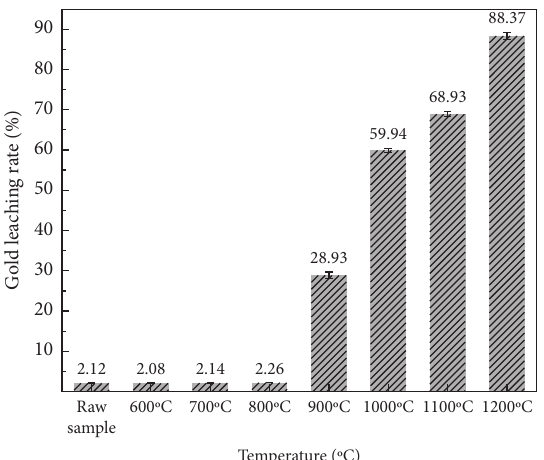
Figure 13: Results of cyanidation tests at different